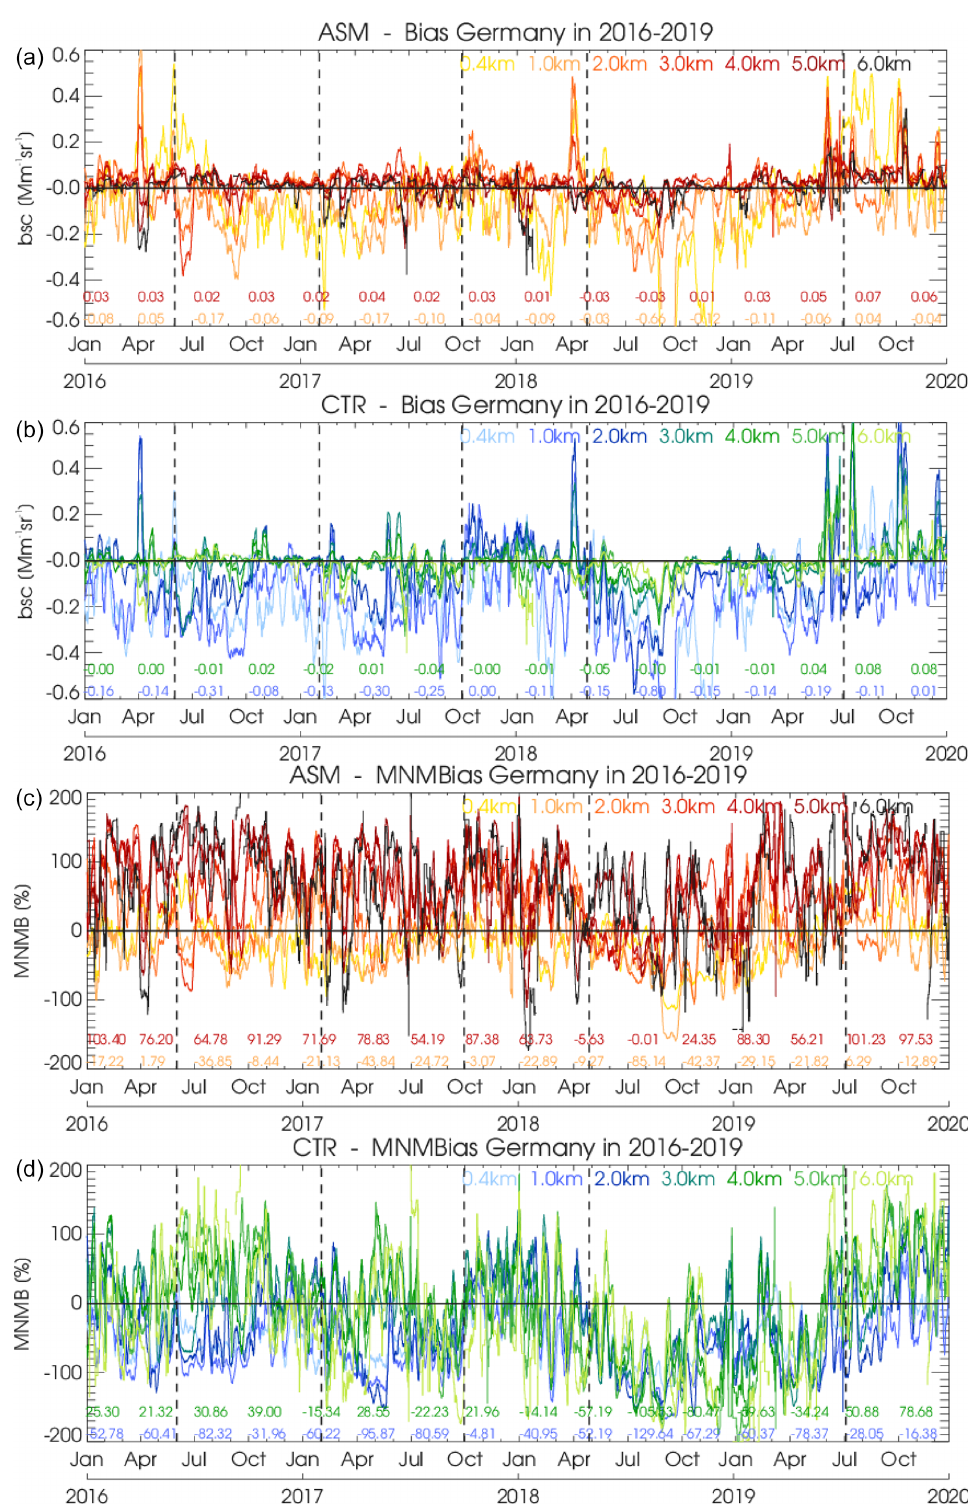
Figure 2. The 7d running mean bias of β ∗ (z) from ASM (a) and CTR (b) combined from 21 German stations in 2016–2019. Same for MNMB in panels (c) and (d) . Colors refer to different altitudes above ground. Vertical black lines indicate major model updates as in Table